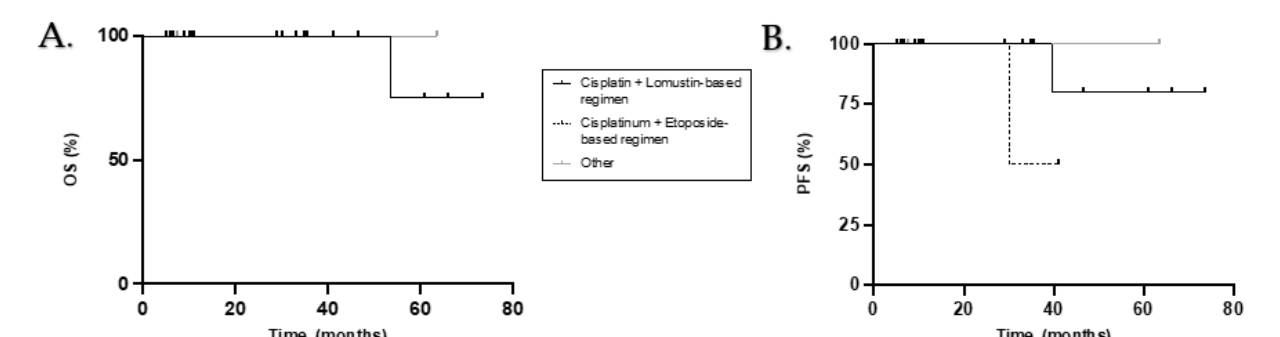
Figure 3. Kaplan–Meier overall survival ( A ) and progress-free survival ( B ) curves for adult patients who received adjuvant chemotherapy according to treatment regimen.